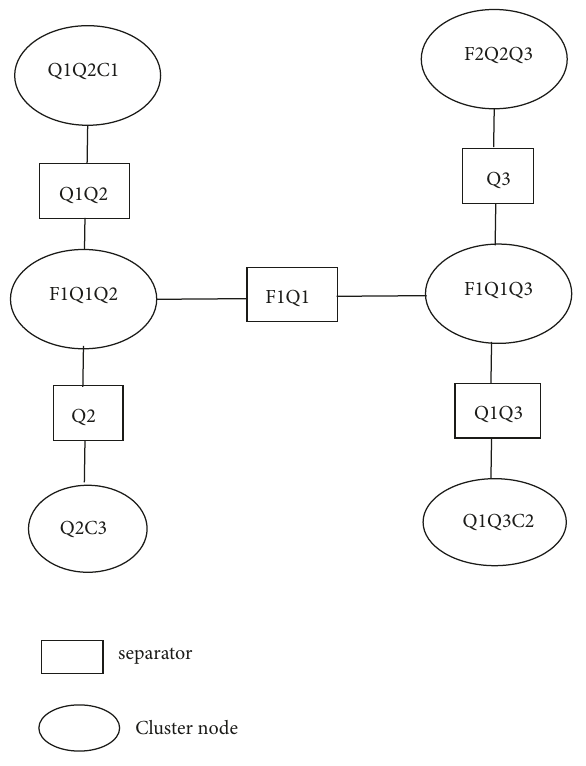
Figure 11: The JT of multifunctional nursing bed. Table 8: The inference conclusions of C 1 in different